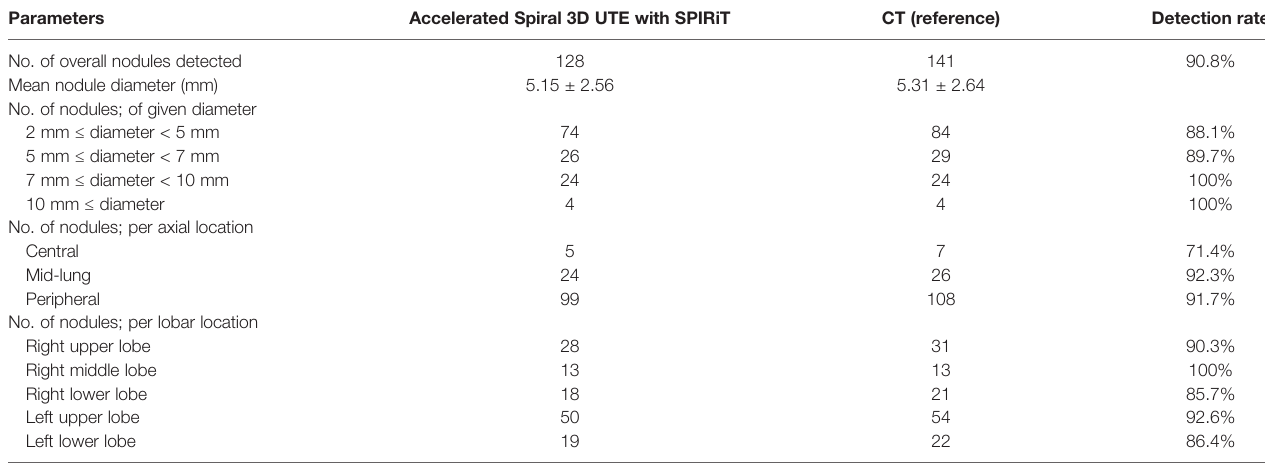
TABLE 2 | Characteristics and detection rate of pulmonary